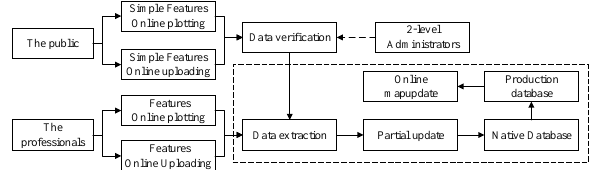
Figure 1. Data collection and verification process